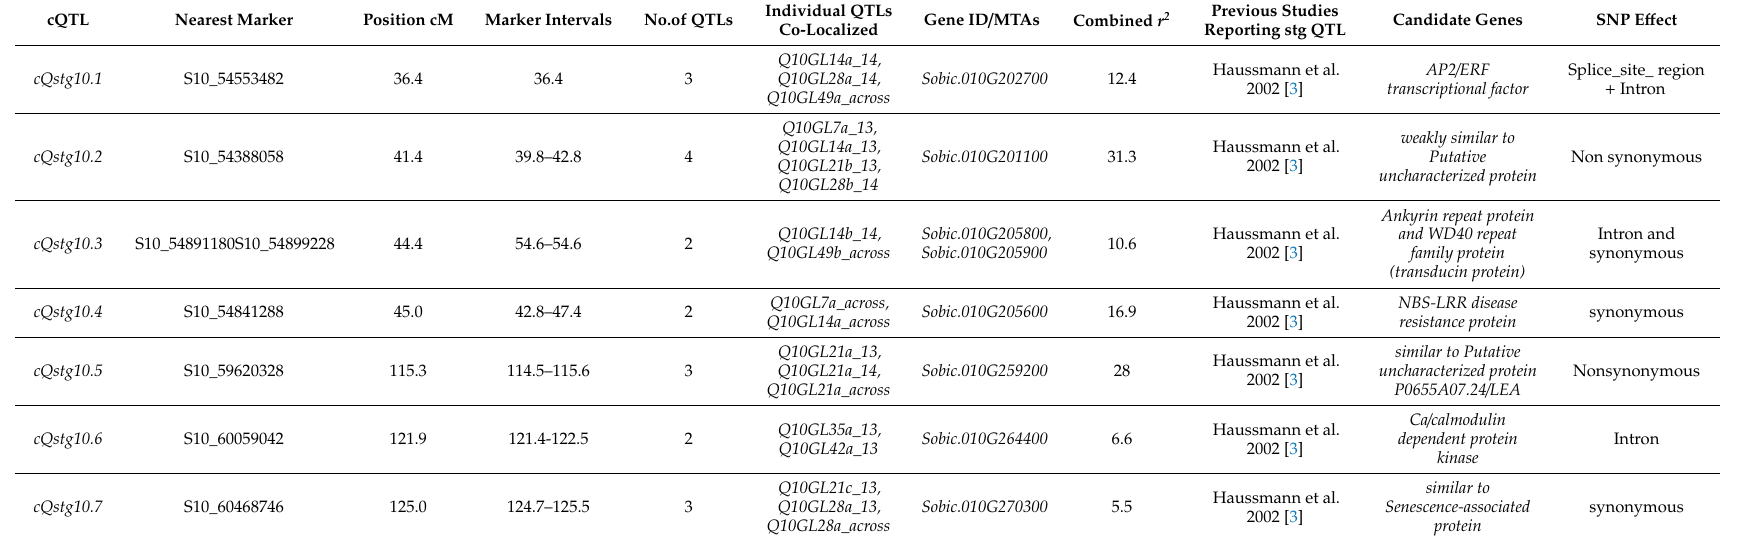
Table 5. Details for the stay-green QTL cluster